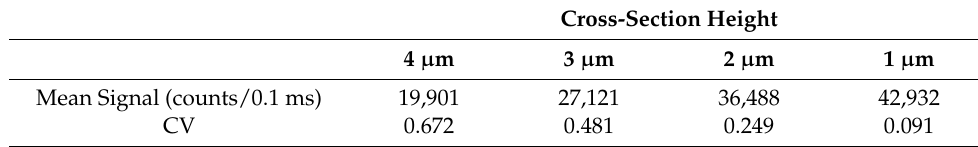
Table 4. Results of hydrodynamically-focused cross-section height optimization.